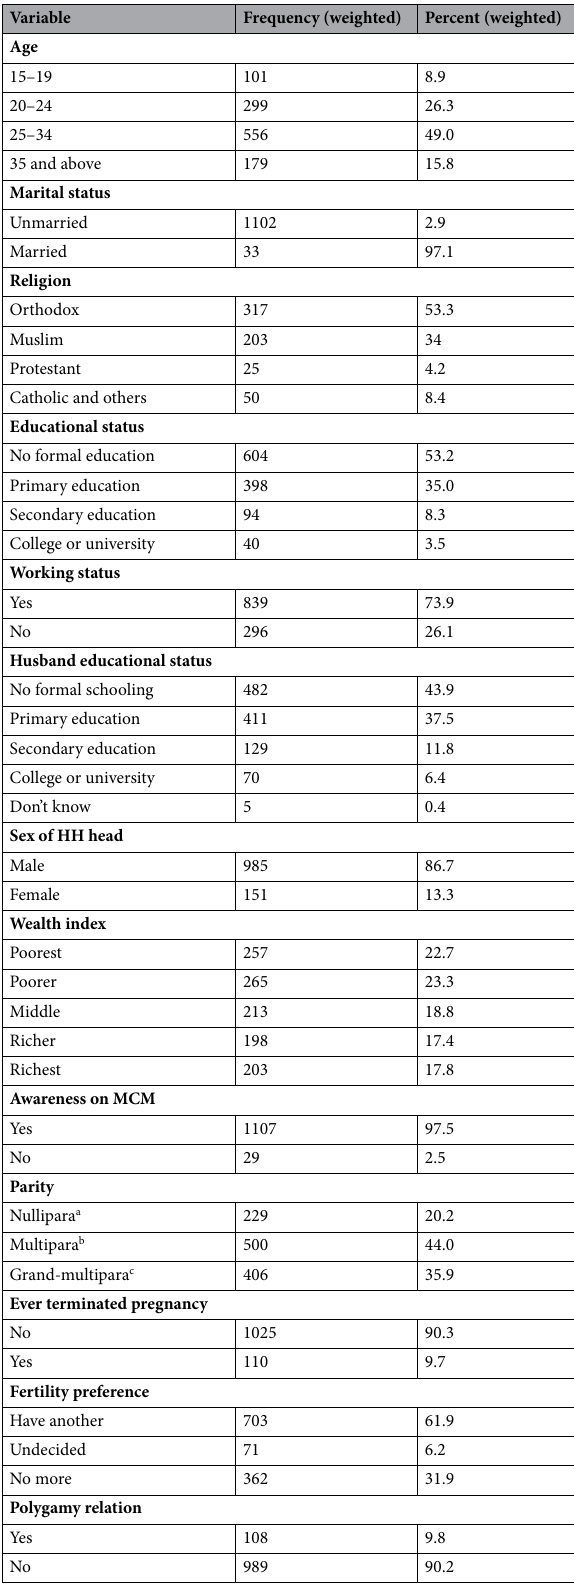
Table 1. Individual-level characteristics of pregnant women from EDHS 2016. a No history of childbirth. b Mothers who have given birth to 1–4 child. c Mothers who have given birth of five and above